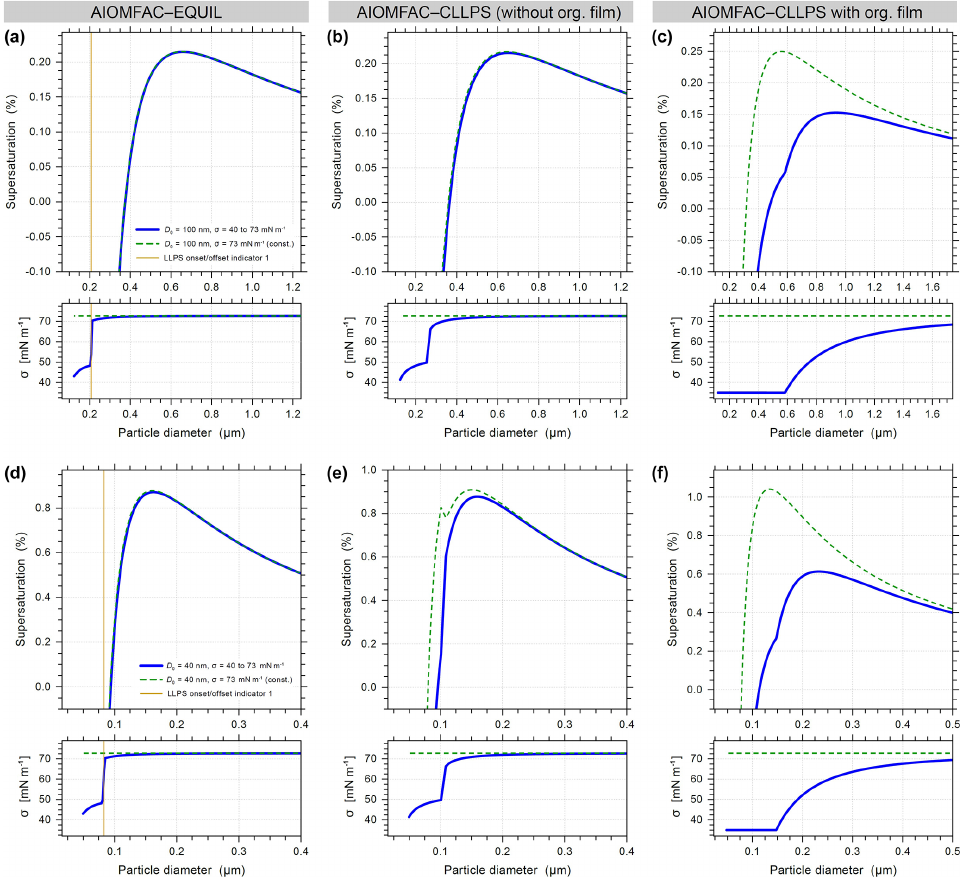
Figure A2. Predicted Köhler curves and associated droplet surface tensions for 100nm (a, b, c) and 40nm (d, e, f) dry diameter particles of ammonium sulfate with suberic acid at f org = 0 . 58 using the AIOMFAC models described in the main text. The AIOMFAC-CLLPS with org. film gives the closest predictions to the experimental observations and predicts similar-shaped curves to those measured experimentally by Ruehl et al.